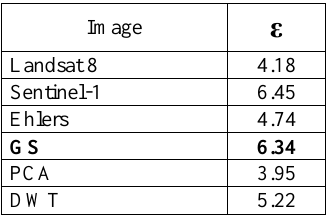
Table 3. Entropy measurements of the image fusion results and